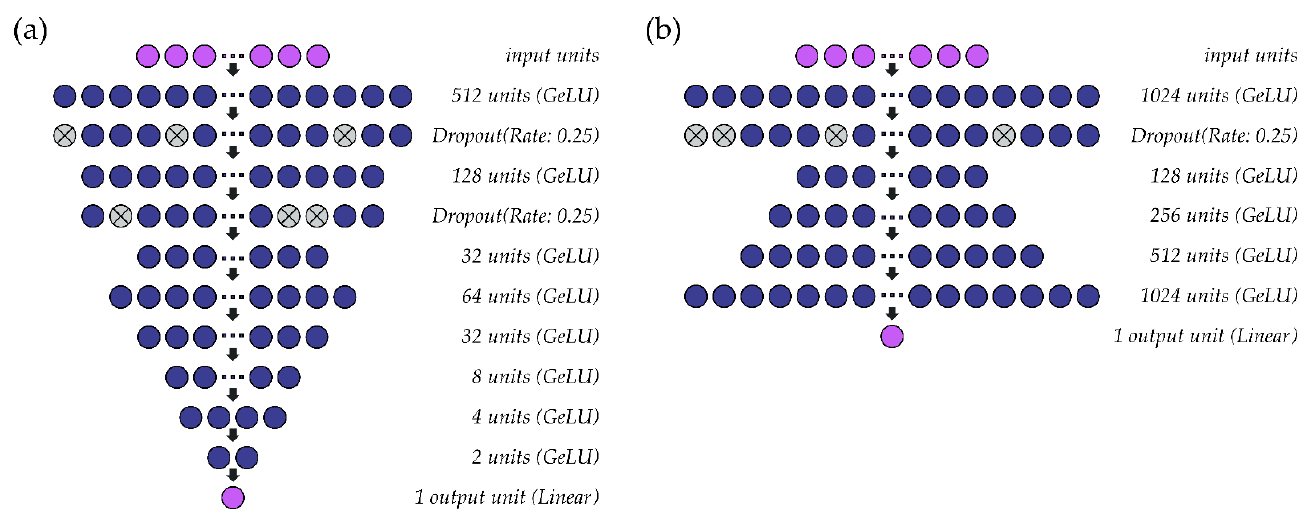
Figure 2. Structure of the single-speaker deep regression neural networks used to estimate ( a ) f o and ( b ) intensity from sEMG signals.